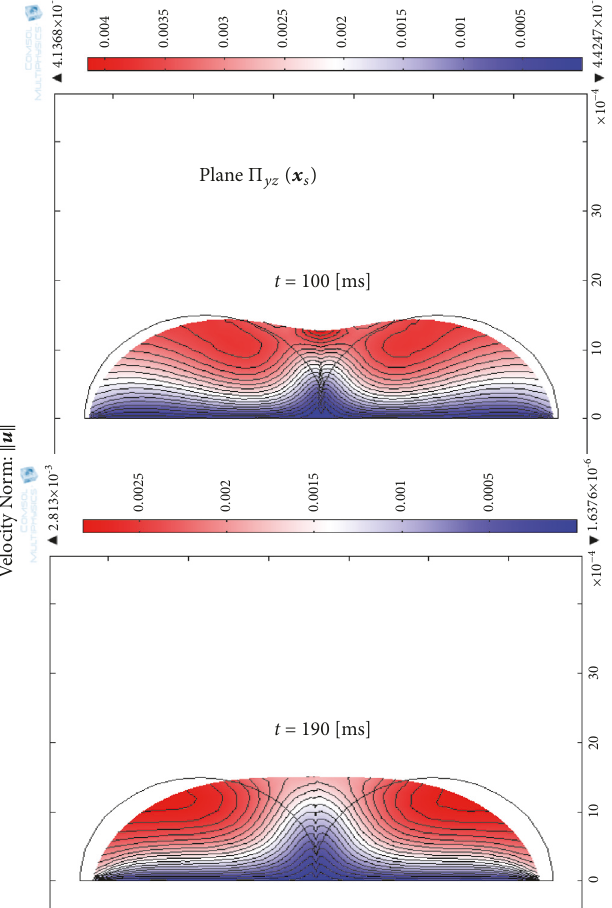
Figure 14: Two-dimensional plots of the velocity norm ‖ u ‖ of two interacting droplets of the same radius 𝑅 1 = 𝑅 2 on the plane Π 𝑥𝑧 ( x 𝑠 ) at times 𝑡 = 100 , 190 [ms]. The solid lines stand for the iso- ‖ u ‖